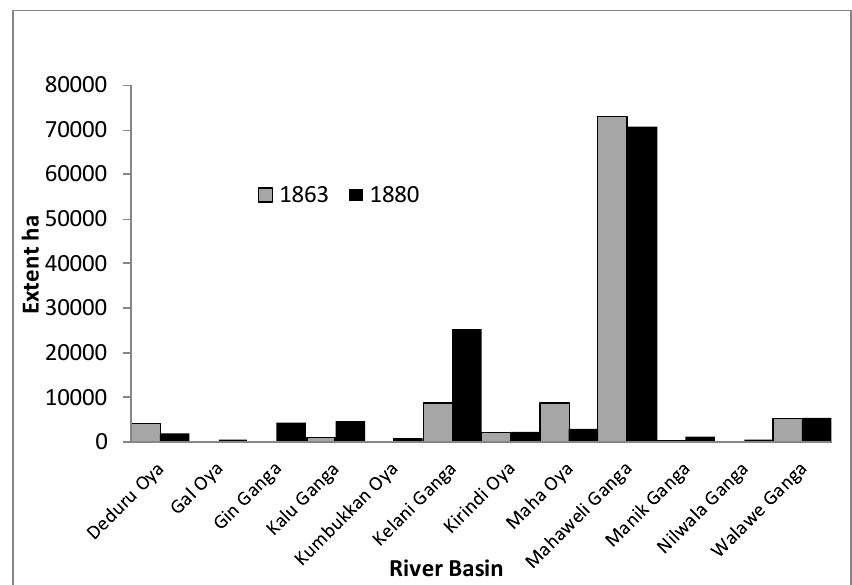
Figure 9: Coffee cultivated area by river basins in Sri Lanka during the British period.